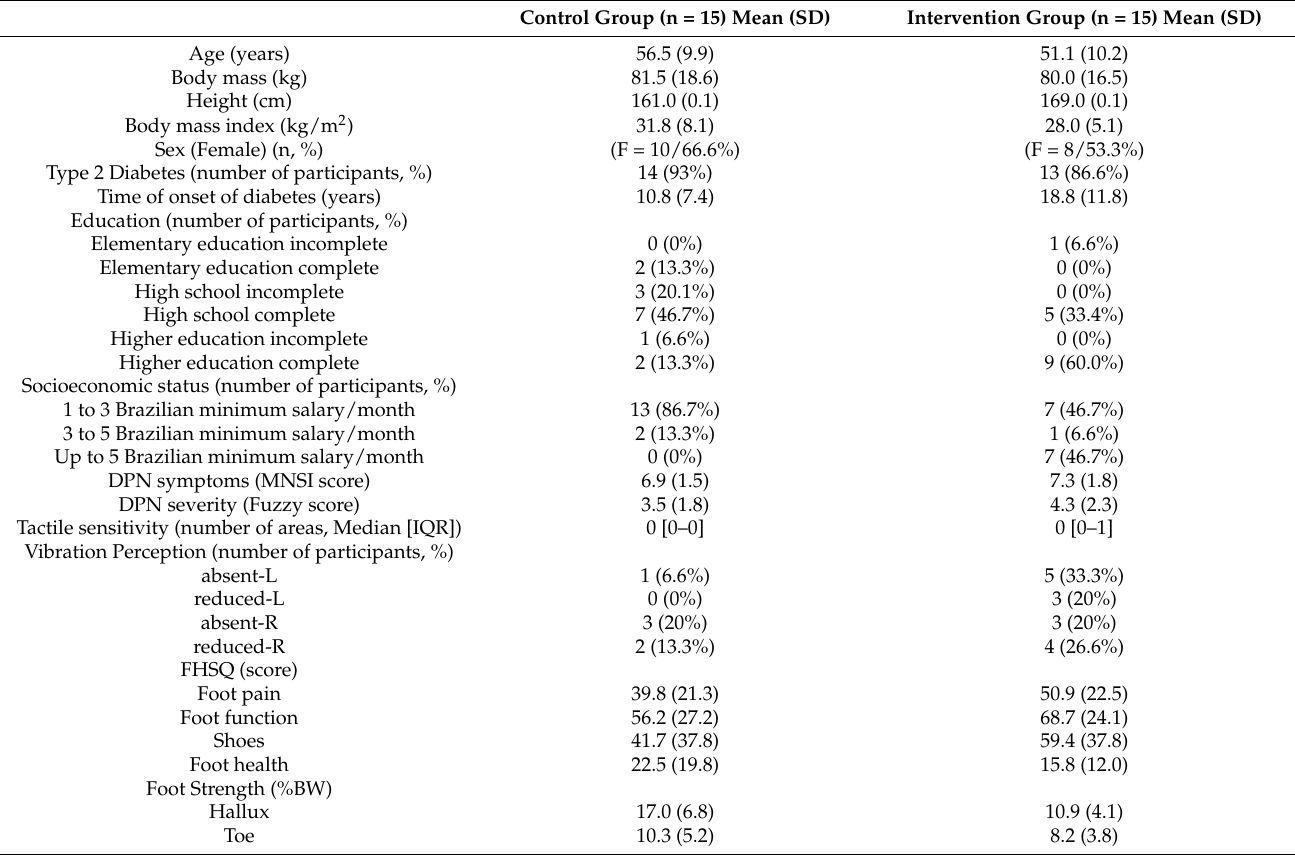
Table 1. Clinical, demographic, and anthropometric outcomes at baseline for the control and inter- vention